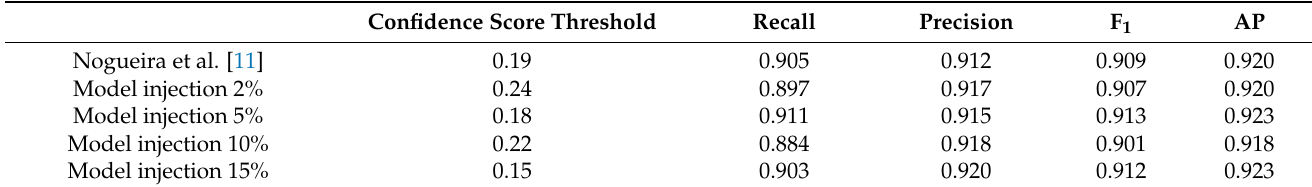
Table 2. Performance metrics in each validation partition for the selected models.